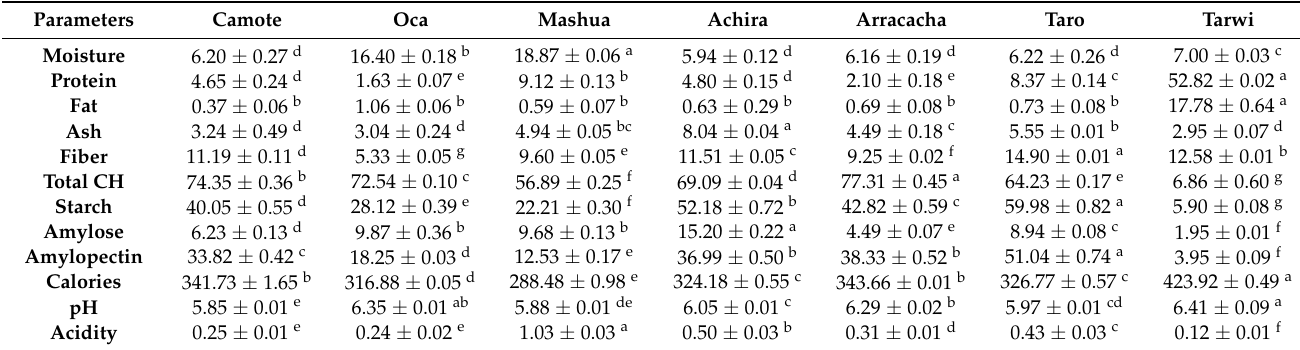
Table 1. Chemical composition of andean crops flours: proximal composition, starch, amylose and amylopectin (%), calories (kcal/100 g), and acidity (expressed as lactic acid percent). Parameters Camote Oca Achira Arracacha Taro Tarwi Moisture